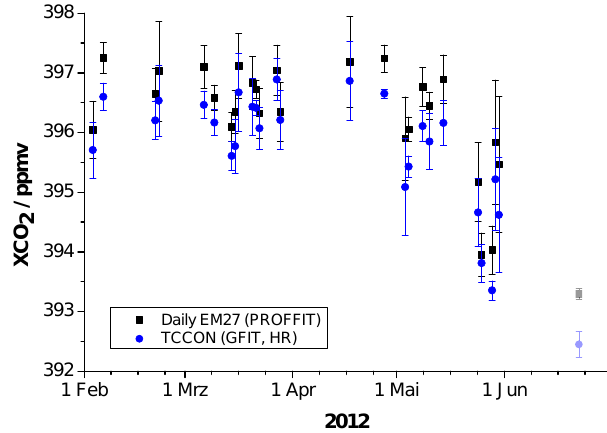
Fig. 9. Daily means of XCO 2 values of the EM27 and the TCCON instrument. The last day is preliminary only.